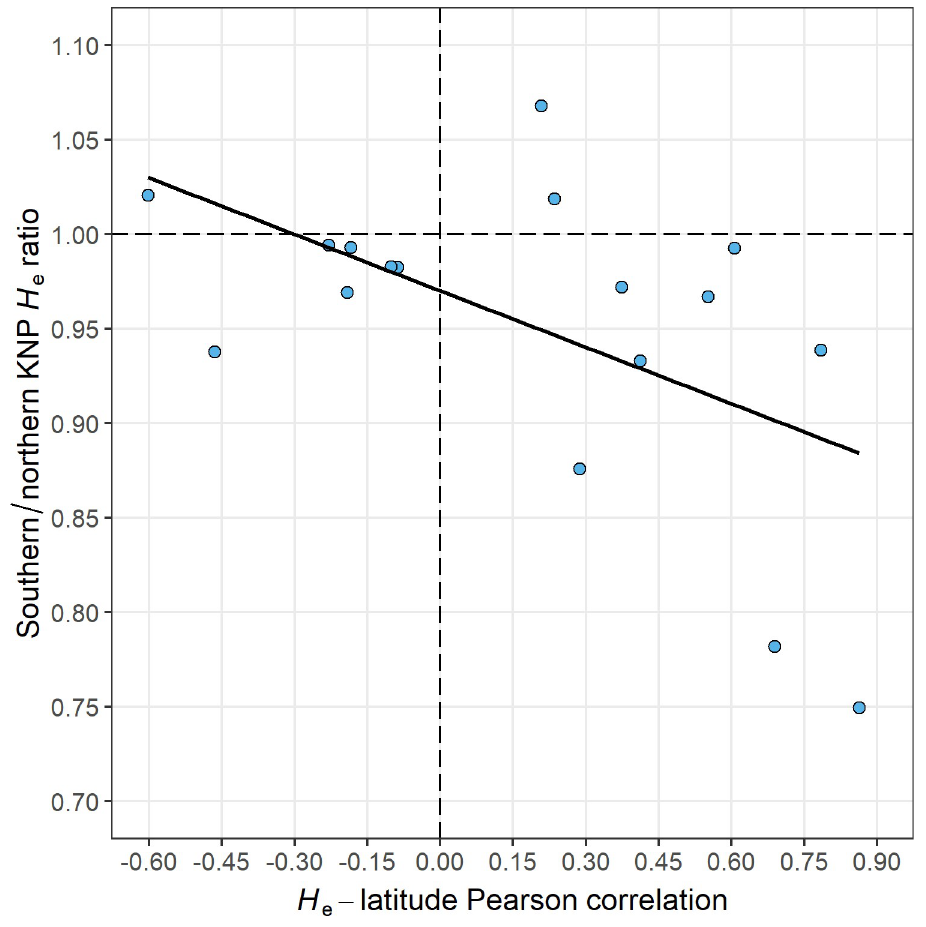
Fig 4. Correlation between per-locus southern/northern KNP H e ratio and H e -latitude Pearson correlation.